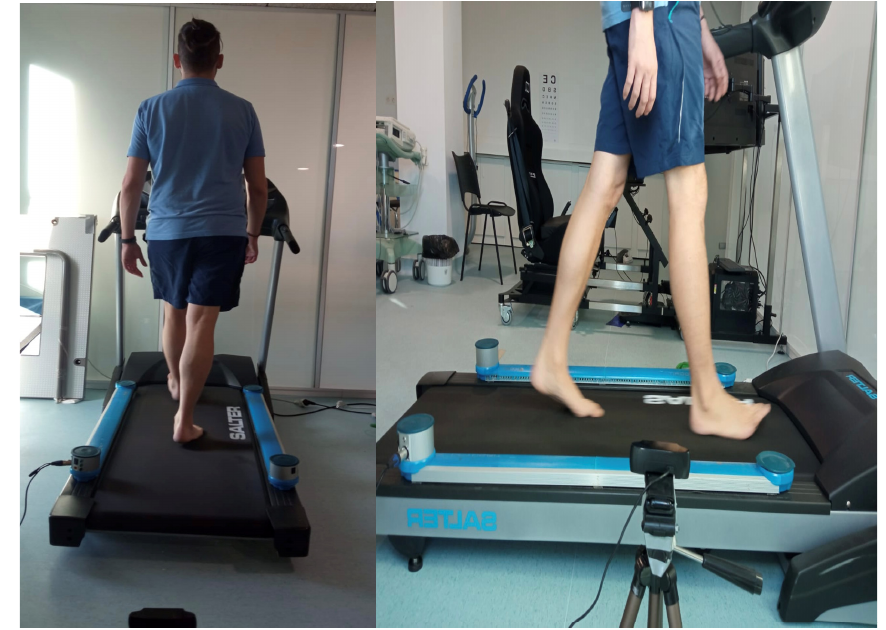
Figure 1. Assessment of the gait cycle using Optogait ©.